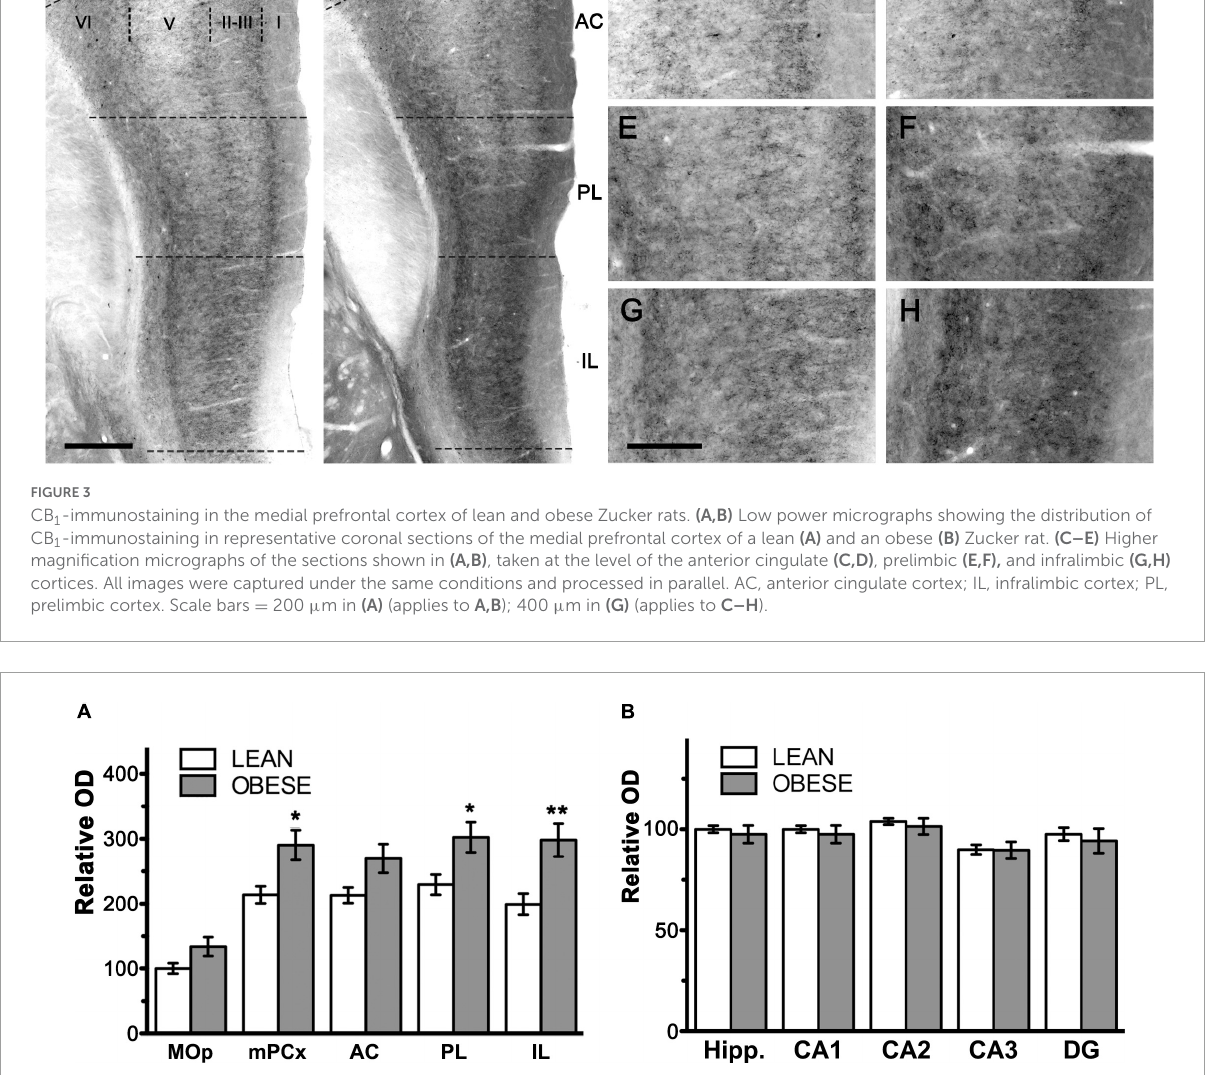
FIGURE4 Bar graphs showing the results of semi-quantitative analysis of CB 1 -immunoreactivity in coronal sections through the medial prefrontal cortex and hippocampal formation of lean and obese Zucker rats. (A) Results of the analysis in subregions of the medial prefrontal cortex. AC, anterior cingulate cortex; IL, infralimbic cortex; MOp, motor primary cortex; mPCx, medial prefrontal cortex; PL, prelimbic cortex. (B) Results of the analysis in subregions of the hippocampal formation. CA1, field CA1 of the Ammon’s horn; CA2, field CA2 of the Ammon’s horn; CA3, field CA3 of the Ammon’s horn; DG, dentate gyrus ; Hipp., hippocampal formation. Data in (A,B) are mean ± SEM; n = 5 in each group. Asterisks indicate the significance of the difference between genotypes for a given cortical area (two-way ANOVA followed by post hoc Bonferroni’s test). * P < 0.05, ** P <